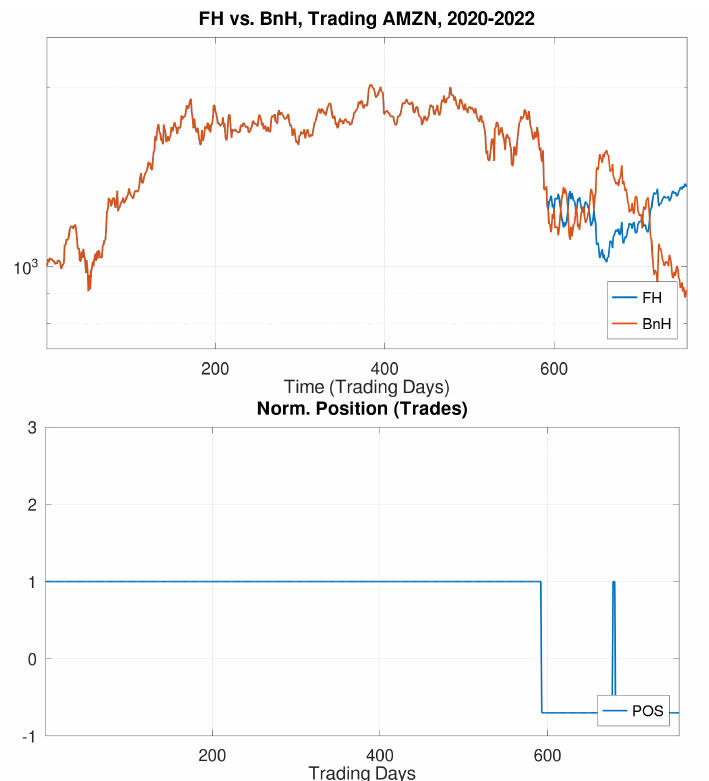
Figure 6. Performance of a FastHedge trading strategy for AMZN stock in the 3-year period 2020– 2023, including portfolio gains as well as the trades made.